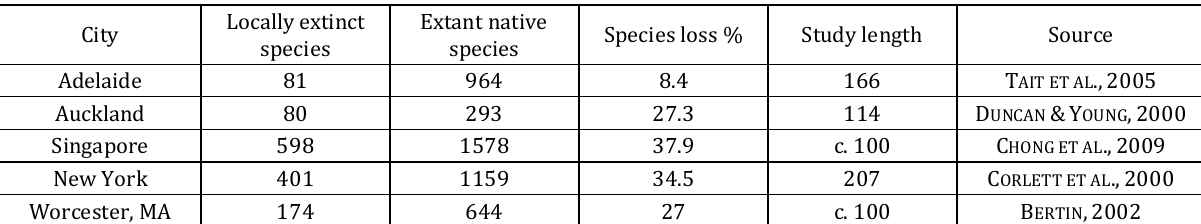
Table 3. The number of native species that became locally extinct in the study period and the number of native species that persisted (extant) in the given cities (see abbreviation key for Table